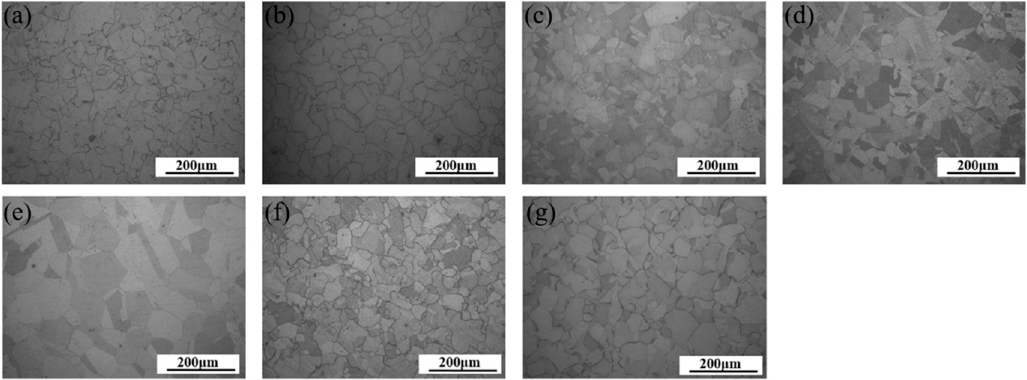
Figure 5. Microstructures of Ni sheets with annealing temperature of 100 µ m: ( a ) 750 ◦ C, ( b ) 850 ◦ C, ( c ) 950 ◦ C, ( d ) 1050 ◦ C, ( e ) 1150 ◦ C; 200 µ m: ( f ) 750 ◦ C, ( g ) 850 ◦